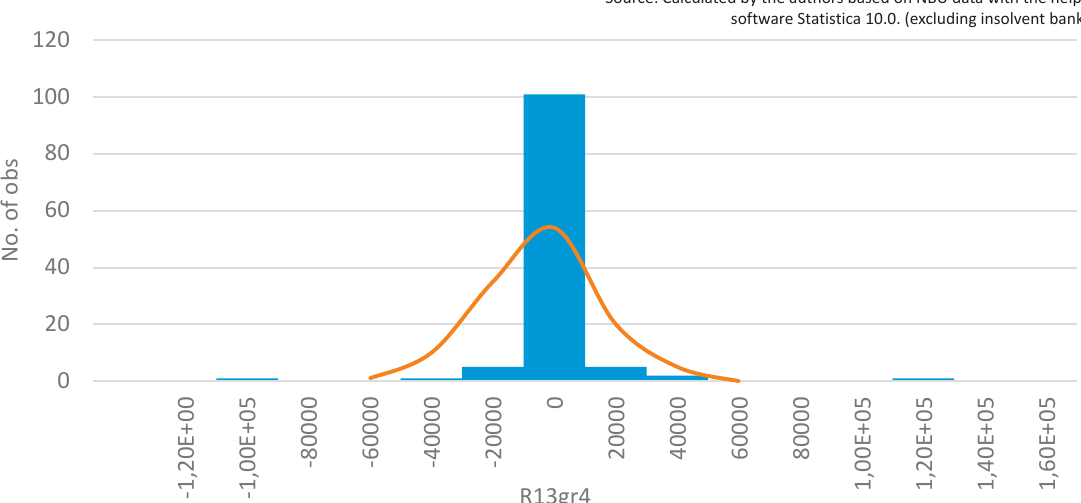
Figure 4. (cid:44)(cid:349)(cid:400)(cid:410)(cid:381)(cid:336)(cid:396)(cid:258)(cid:373)(cid:3)(cid:381)(cid:296)(cid:3)(cid:282)(cid:349)(cid:400)(cid:410)(cid:396)(cid:349)(cid:271)(cid:437)(cid:415)(cid:381)(cid:374)(cid:3)(cid:381)(cid:296)(cid:3)(cid:396)(cid:286)(cid:410)(cid:437)(cid:396)(cid:374)(cid:400)(cid:876)(cid:367)(cid:381)(cid:400)(cid:400)(cid:286)(cid:400)(cid:3)(cid:381)(cid:296)(cid:3)(cid:271)(cid:258)(cid:374)(cid:364)(cid:400)(cid:3)(cid:381)(cid:296)(cid:3)(cid:336)(cid:396)(cid:381)(cid:437)(cid:393)(cid:3)(cid:1008)(cid:3)(cid:349)(cid:374)(cid:3)(cid:1006)(cid:1004)(cid:1005)(cid:1007)